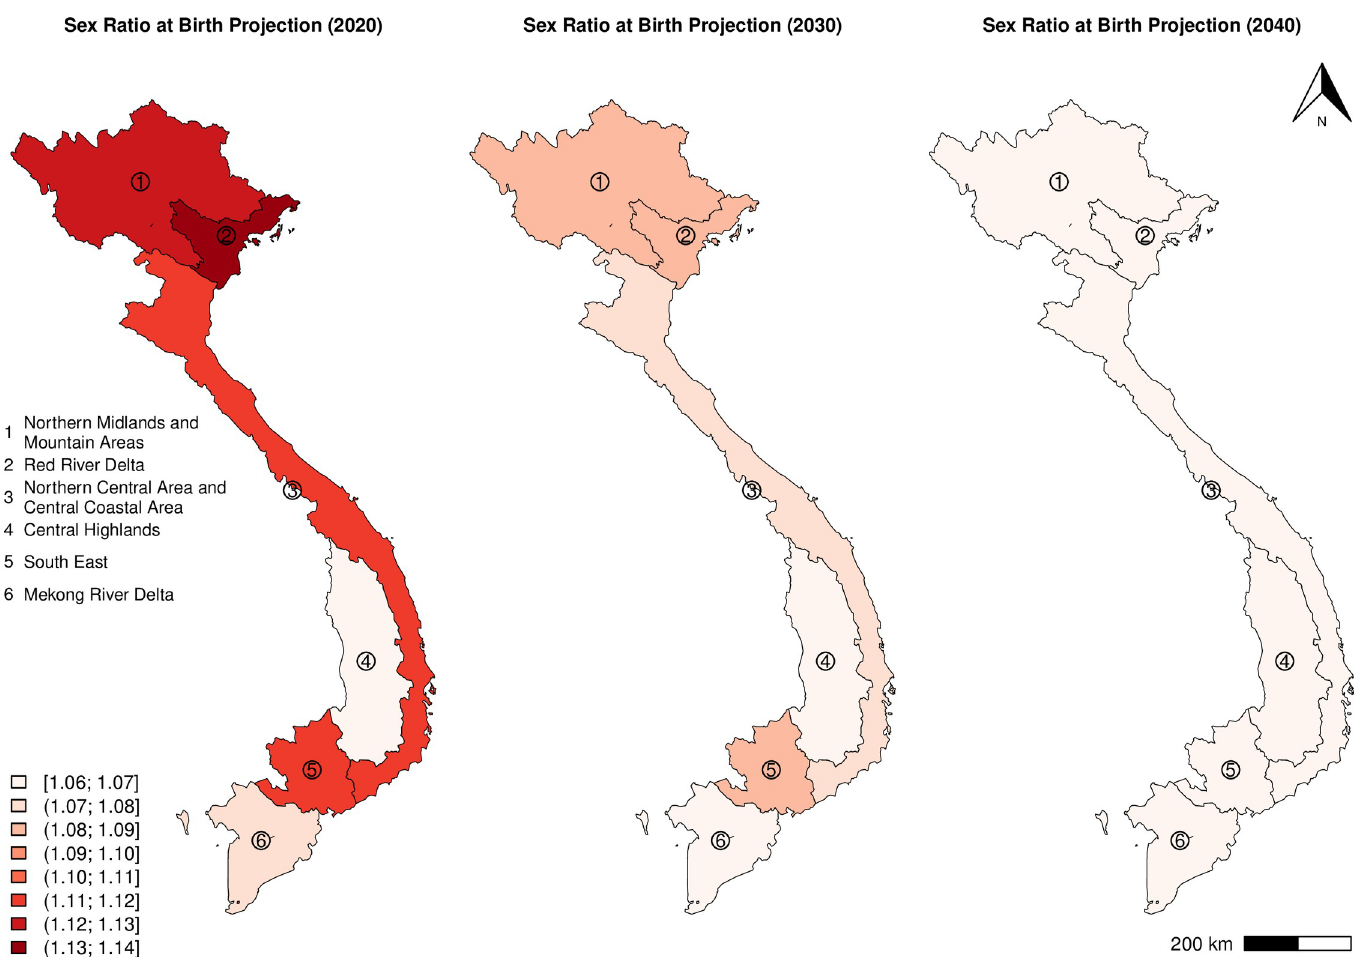
Fig 4. SRB median projections in Vietnam by region in 2020, 2030, and 2040. Maps only show mainland Vietnam.